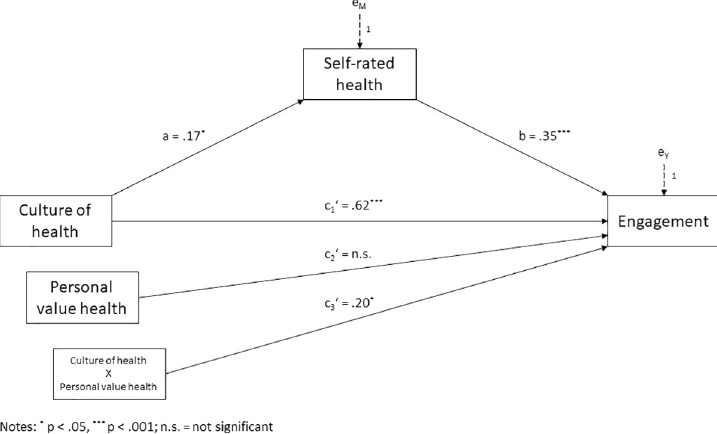
Fig 4. Moderated mediation model. Health as personal value moderating and self-rated health mediating the effect of workplace culture of health on employee engagement.